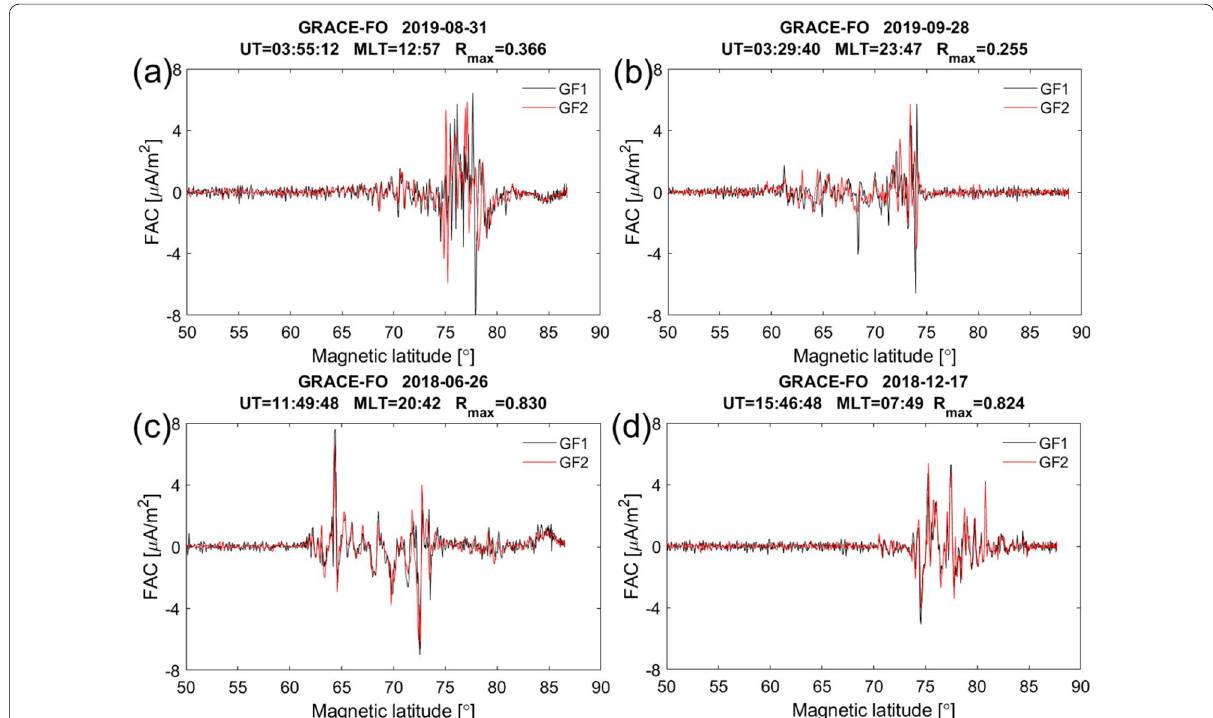
Fig. 7 Four individual examples of the FACs profiles from GF1 and GF2, representing the situations around a noon, b midnight, c dusk and d dawn